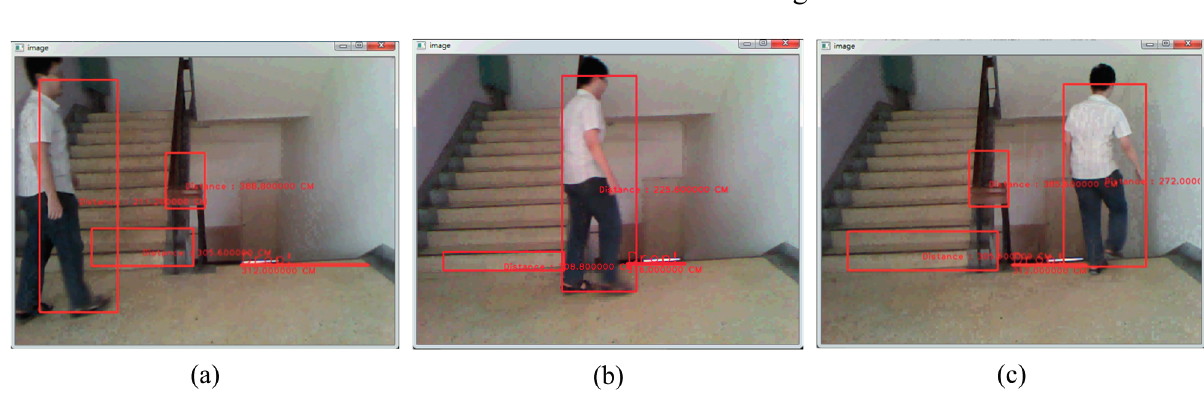
Figure 26. The detection of static and dynamic obstacles. ( a ) Walking people walks from the left side; ( b ) Walking people at the middle; ( c ) Walking people walks to the right side.